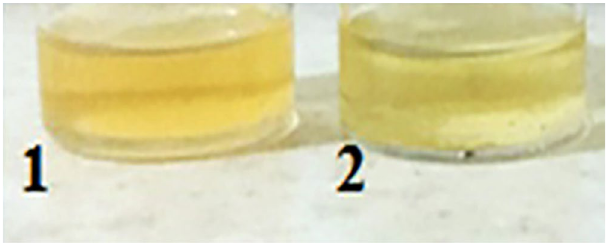
Figure 6. 1—cPNIPAAM solution in DMF; 2—cPNIPAAM solution in water before lyophilizing.